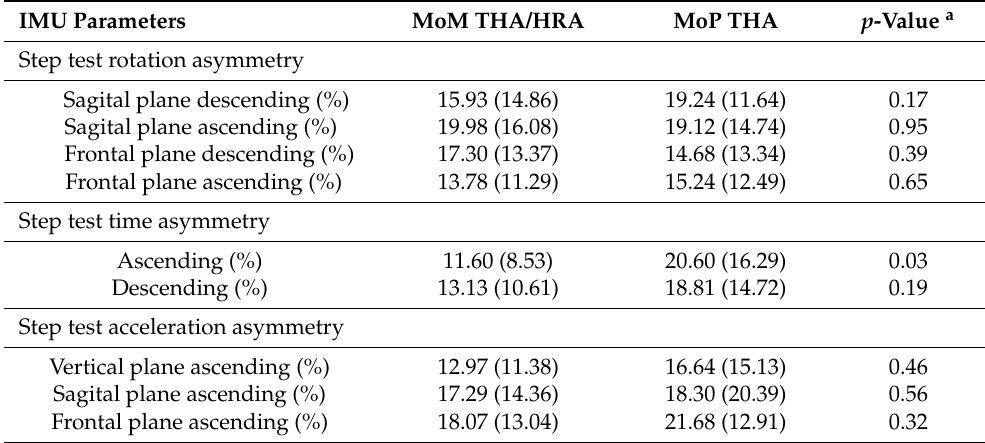
Table 4. Inter-limb difference in trunk Range of Motion in the sagittal and frontal plane measured from step test obtained in the MoM THA/HRA ( n = 45) and MoP THA ( n = 19) group, respectively. Values are mean